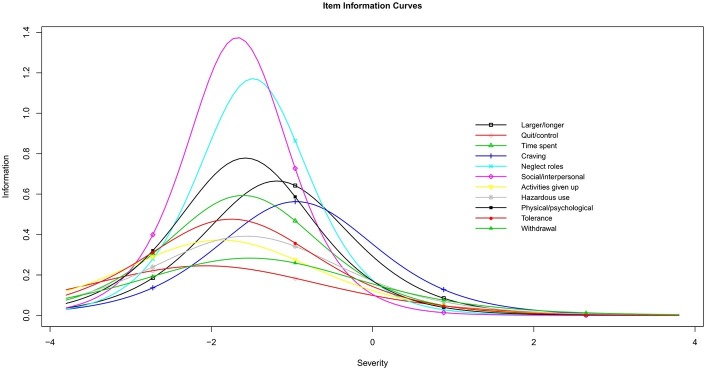
Item information curves for DSM-5 heroin use disorder criteria.